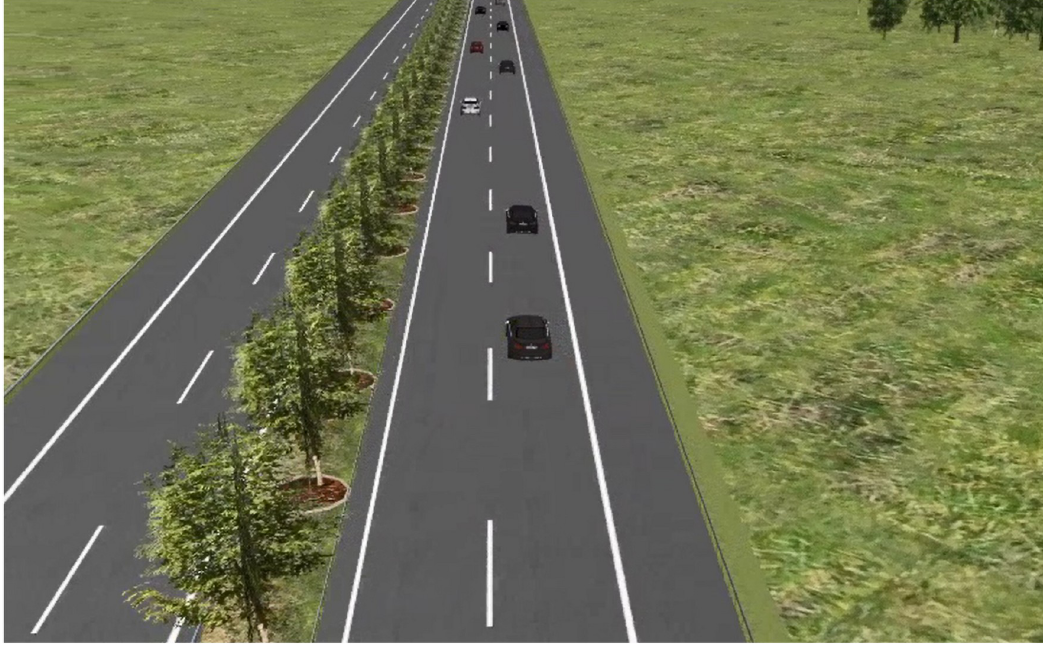
Fig 11. Video during normal driving